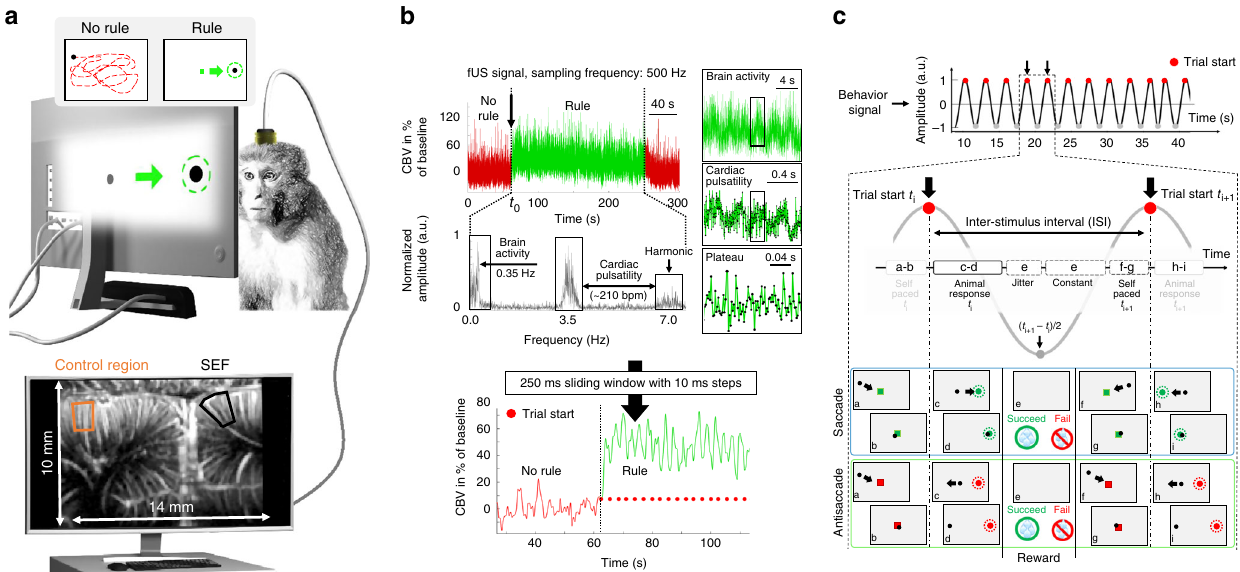
Fig. 1 Setup and signal information. a The high sensitivity to cerebral blood volume (CBV) changes in fUS (functional ultrasound) imaging enable the single trial detection of supplementary eye fi eld (SEF) activation during visual tasks. The animals performed in a row with baseline (rest phase), fi xation, saccade, and antisaccade trials while CBV changes were recorded in fUS with a FOV of 10 × 14 mm. b fUS signal was recorded at a sampling frequency of 500 Hz the SEF region; below is the associated spectrum (fast Fourier transform) of the SEF signal during the visual task. Peaks frequency observed at 0.35 and 3.5 Hz are related to brain activity and cardiac pulsatility (~ 210 bpm), respectively (7 Hz is a harmonic frequency of cardiac pulsatility). To obtain a cleaner signal, cardiac pulsatility was fi rst removed with a cutoff fi lter, and then a 250 ms sliding window with a time increment of 10 ms was applied in each pixel of the image. c Behavior signal consists of a sinusoid for which each period was de fi ned by the time between trial start t i and the following trial start t i + 1 . Jitter and constant time were similar for all type of task; the only signi fi cant variation between visual tasks was the animal response time (RT). Each visual task was initialized by the animal ( a , b ), for saccade he has to hit the cue ( c , d ) whereas for antisaccade he has to hit the opposite side where the cue appeared ( c , d ) and fi nally for the fi xation task (not represented in the fi gure) he has to keep its eye ’ s position on the initial cue. Depending on the result, the animal received a reward ( e ) and he then could initialize a new trial sequence ( f – i